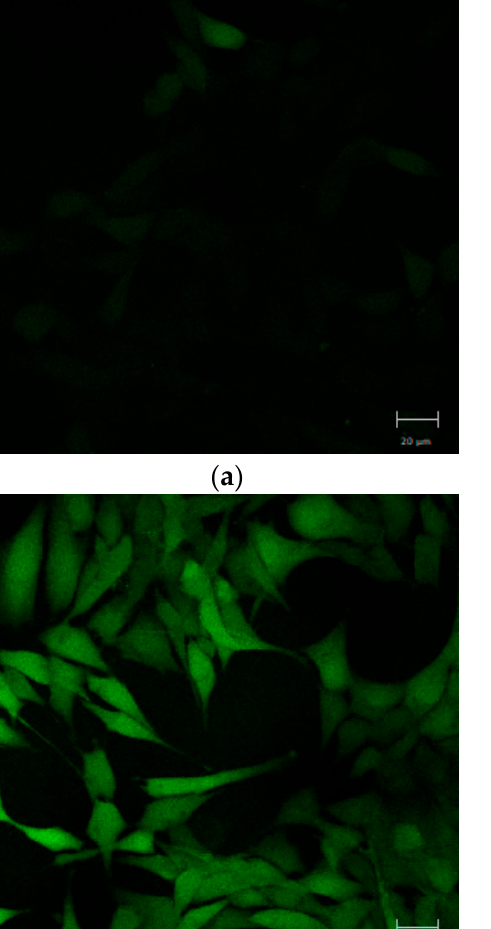
( e ) Figure 2. Inhibitory effect of KP extract against glutamate-induced oxidative stress in HT-22 cells. HT-22 cells were treated with 5 mM glutamate alone or co-treatment of glutamate with various concentrations of KP extract for 14 h. The production of intracellular reactive oxygen species (ROS) was stained by 2 ′ , 7 ′ -dichlorodihydro fluorescein diacetate (H 2 DCFDA) and observed under a fluo- rescence microscope. ( a ) Untreated cells (control); ( b ) 5 mM of glutamate; ( c ) 75 μ g/mL of KP extract + 5 mM of glutamate; ( d ) 0.25 mM of N-acetyl cysteine (NAC) + 5 mM of glutamate; ( e ) the quantity of production of intracellular ROS was measured using H 2 DCFDA by the fluorescence microplate reader. All data are shown as the mean ± SEM of at least three independent experiments. * p < 0.05 and *** p < 0.001 vs. the glutamate treatment alone. The symbol "-" and "+" are defined as absent and present, respectively.